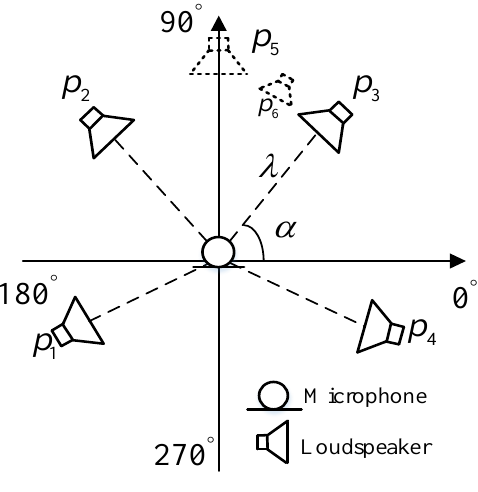
Figure 4. Location of microphones and